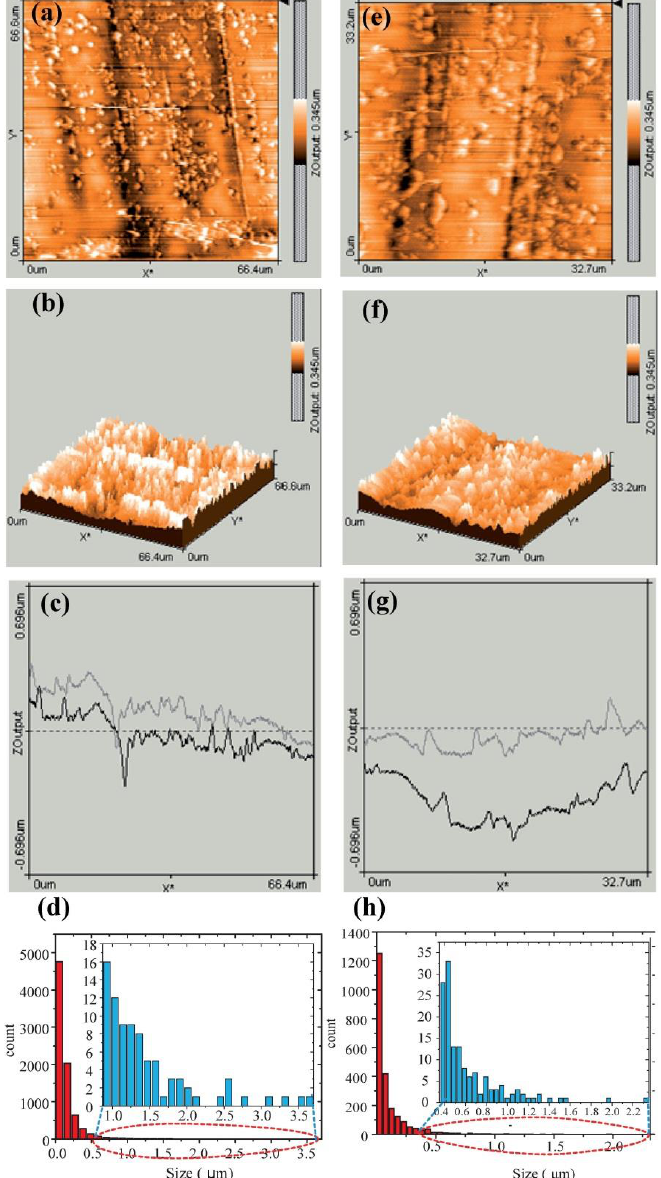
Figure 4. AFM images of the nanocluster deposited at a pressure, voltage, and current of 25 mbar, 0.25 kV, and 240 mA, respectively. ( a , b ) Two-dimensional and 3-dimensional views of the low-resolution AFM scan of 66.4 µ m × 66.6 µ m. ( c , g ) AFM scan profile for low-resolution and high resolution captured during scanning. ( d ) Histogram of nanocluster size shown in ( a , b ). ( e , f ) Two-dimensional and 3-dimensional views of the high-resolution AFM scan of 32.7 µ m × 32.2 µ m. ( h ) Histogram of the nanoclusters of the high-resolution AFM scan, as shown in ( e